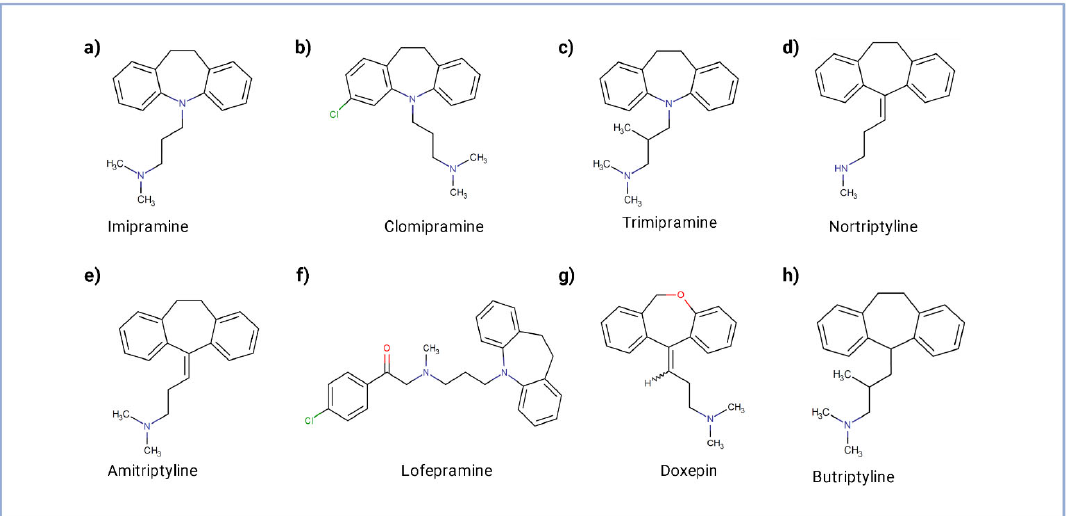
Figure 1. Structure of most common TCAs. ( a – c ) TCAs predominantly act by inhibiting the reuptake of serotonin; ( d ) nortriptyline predominantly by inhibiting reuptakes of norepinephrine; ( e , f ) balanced reuptake inhibitors of serotonin and norepinephrine; ( g , h ) balanced reuptake inhibitors of serotonin and norepinephrine with additional anti-H1